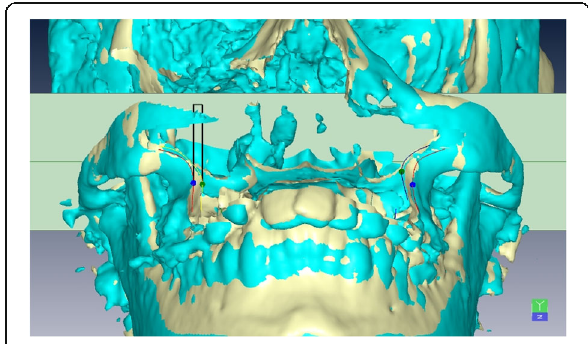
Fig. 4 Distance traveled by R- Max mediolaterally. Green point: Pre- expansion R-Max & L-Max. blue point: Post expansion R-Max & L-Max